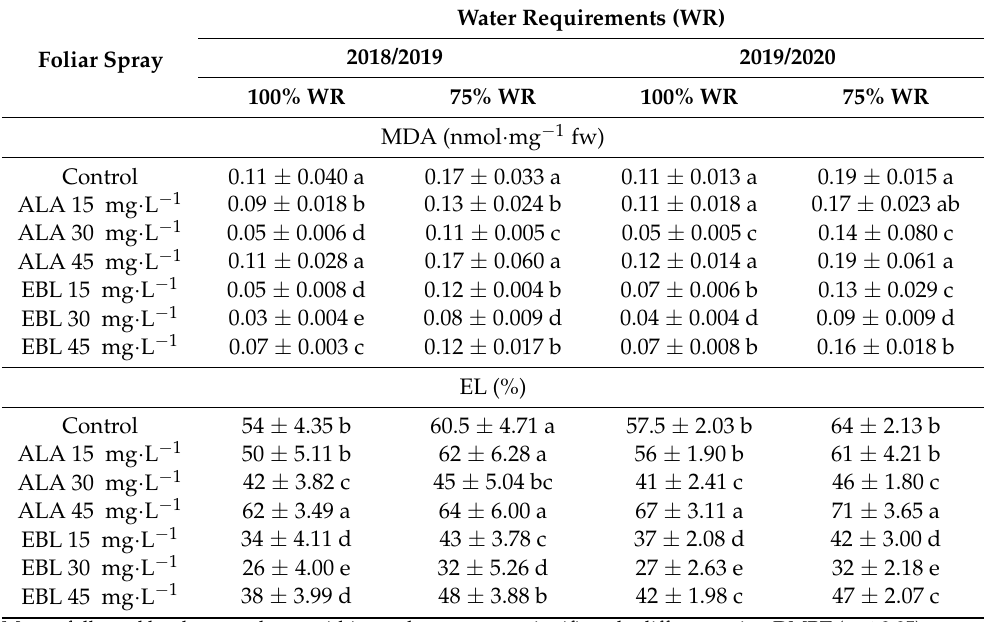
Table 1. Effect of foliar spray with ALA or EBL on the malondialdehyde (MDA) content and electrolyte leakage (EL) of drought-stressed “Williams” banana plants during the 2018/2019 and 2019/2020 seasons ( n =